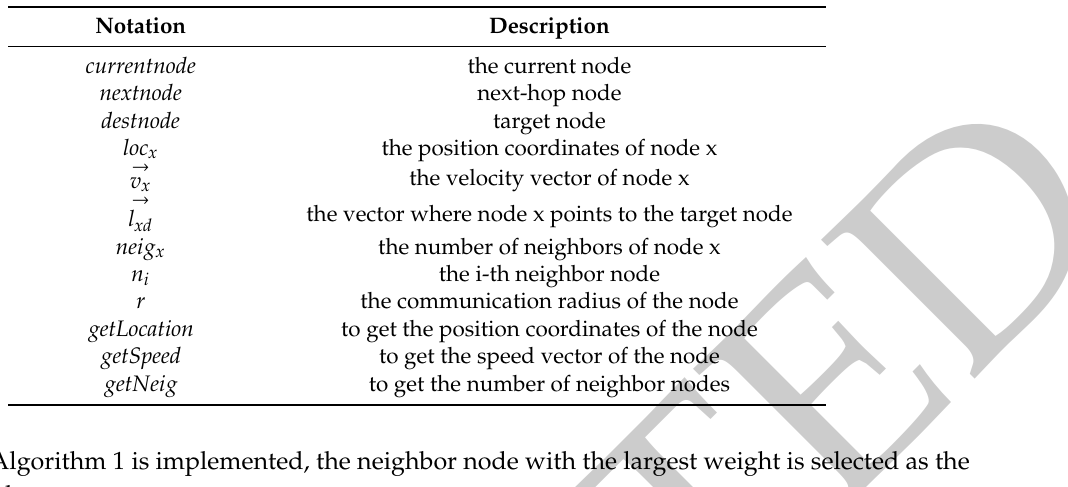
Algorithm 1 Pseudo code for